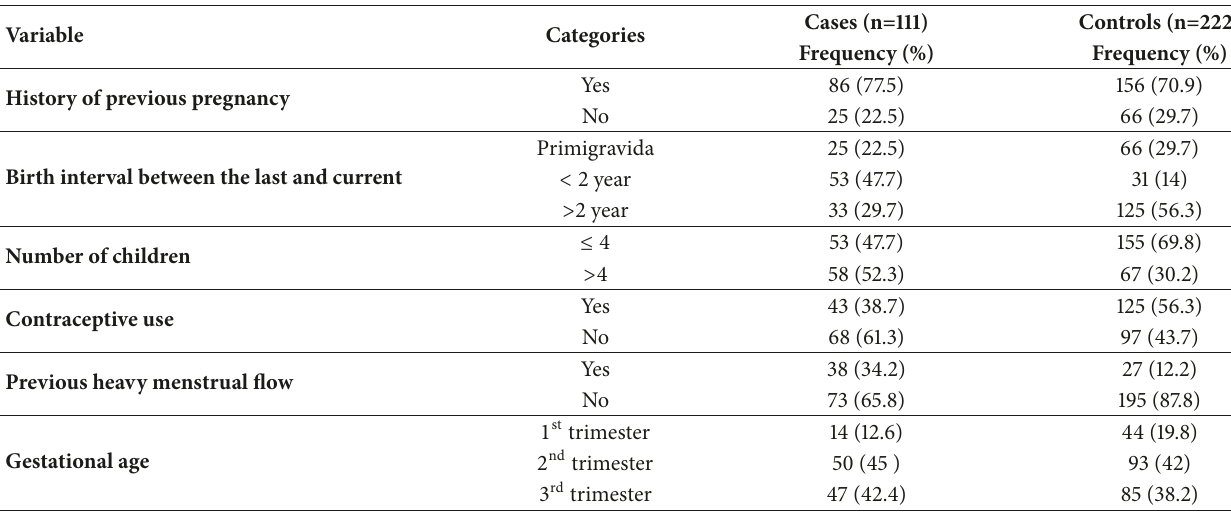
Table 2: Obstetrics related characteristics of pregnant mother attending ANC in public health facilities of Durame Town, February to May